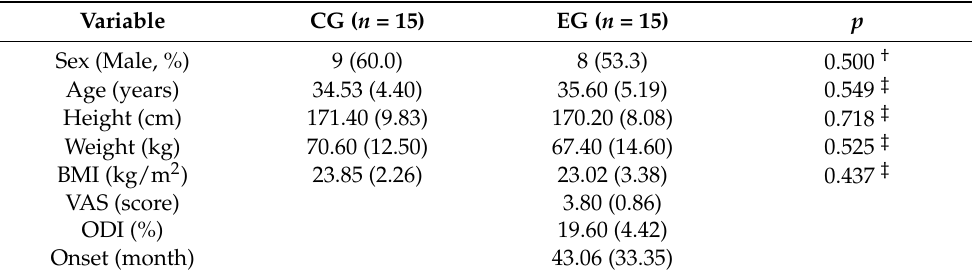
Table 1. General characteristics of the experimental and control